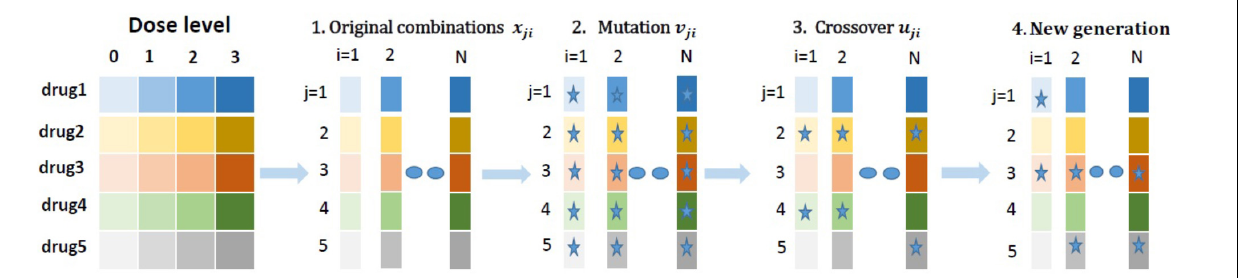
FIGURE 1 | A schematic illustration of differential evolution (DE)